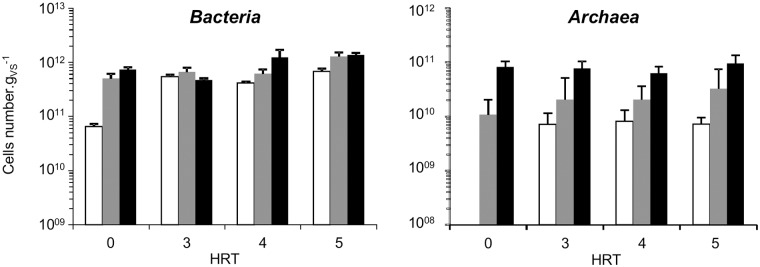
Average enumeration according to the inoculum origin (eco1 in white, eco2 in grey, eco3 in black) of Bacteria (left) and Archaea (right) by q-PCR.The x axis represents the hydraulic retention time. Standard errors are displayed. HRT4 and HRT 5 represent the steady state based on the reactors performances.